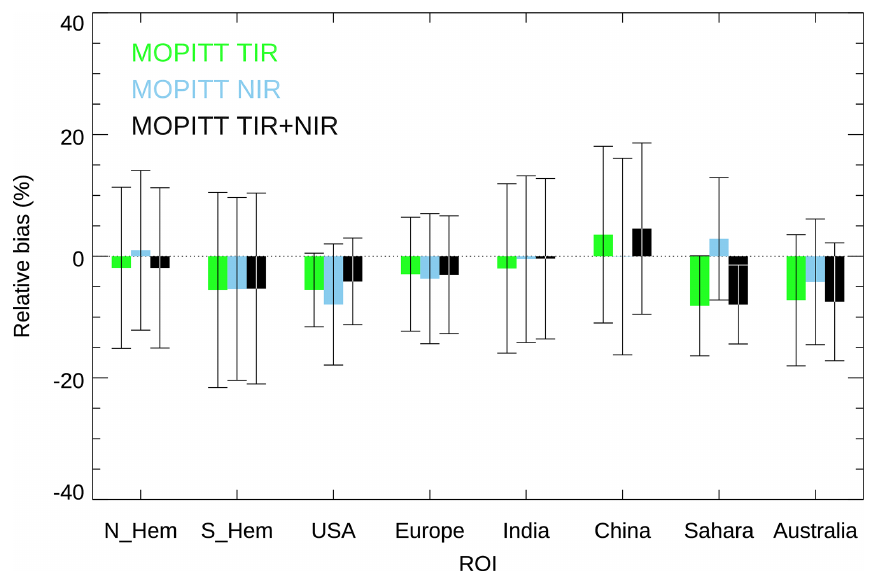
Figure 12. Summary of colocated land comparison results. Colored bars represent relative bias between TROPOMI and each of the three MOPITT products (TIR, NIR, and TIR + NIR); solid lines indicate the SD of the relative bias.